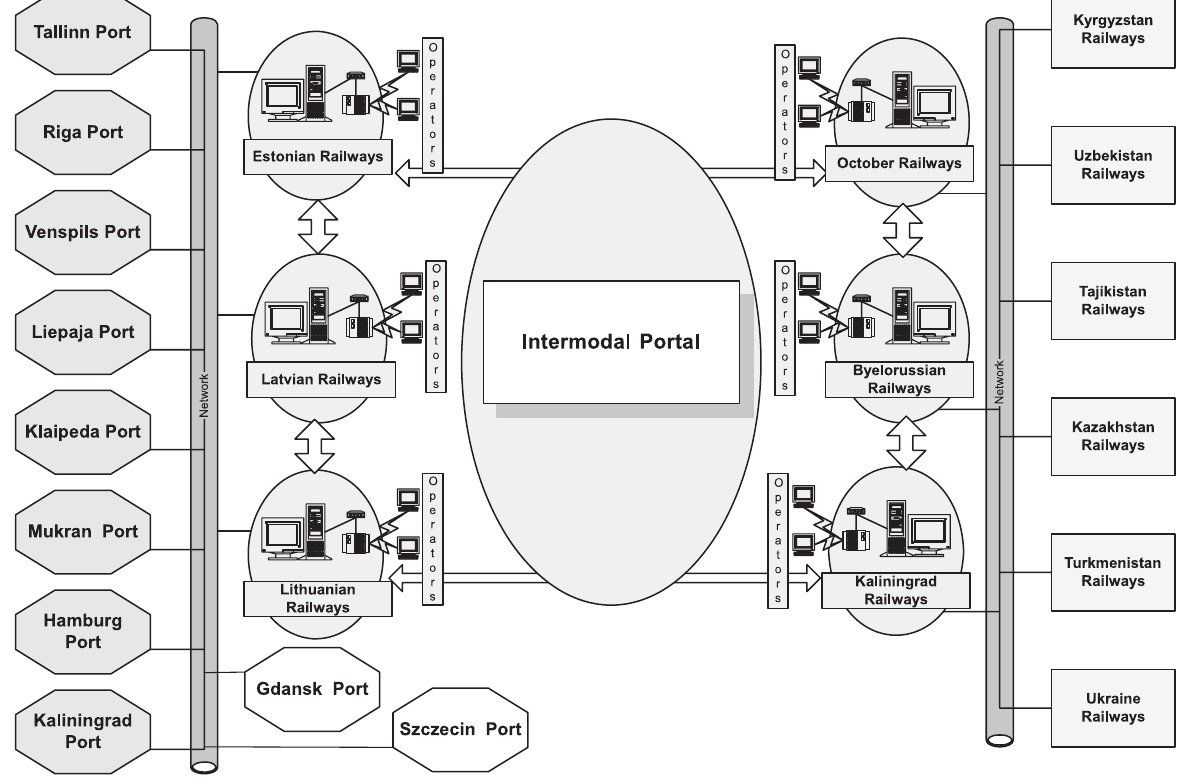
Fig. 4. Architecture of virtual LC